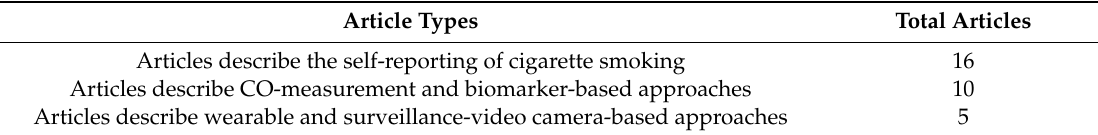
Table 2. Summary of the publication related to classical methods for smoking